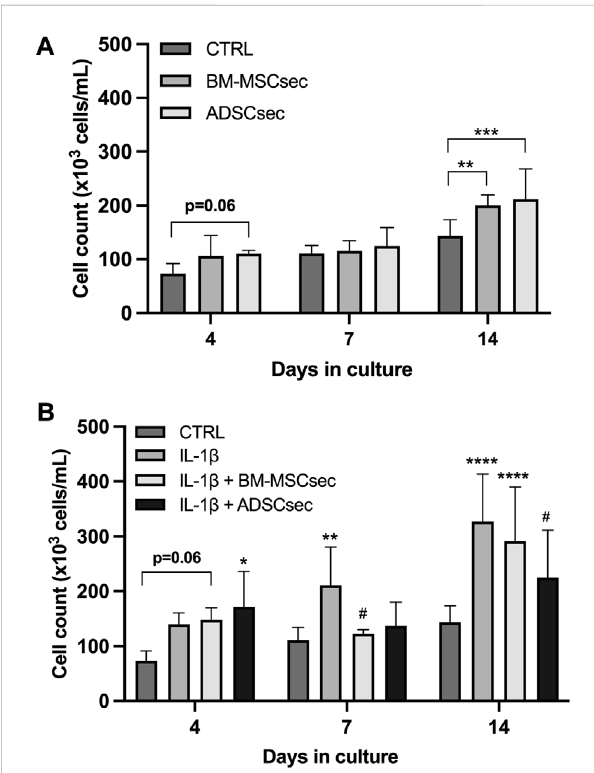
FIGURE 5 MSC-derived secretome increased hNPC proliferation. (A) Both BM-MSCsec and ADSCsec signi fi cantly increased hNPC content at 14 days of culture. (B) After IL-1 β pretreatment, cell numerosity was aberrantly increased at 7 and 14 days compared to the controls. Treatment with BM-MSCsec and ADSCsec resulted in a substantial increase of cell content compared to the control group, while being lower than the group treated with IL-1 β . * p < 0.05, ** p < 0.01, *** p